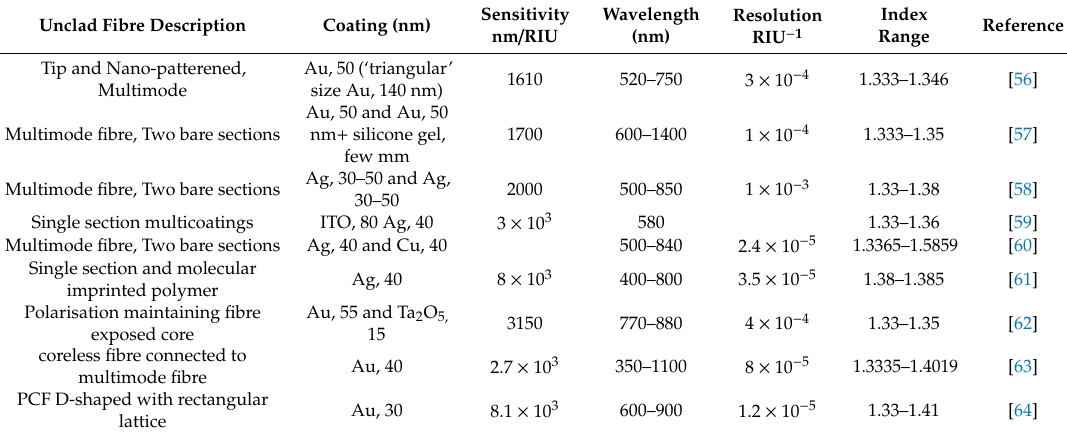
Table 2. Summary of various fibre cladding-removed plasmonic sensors.